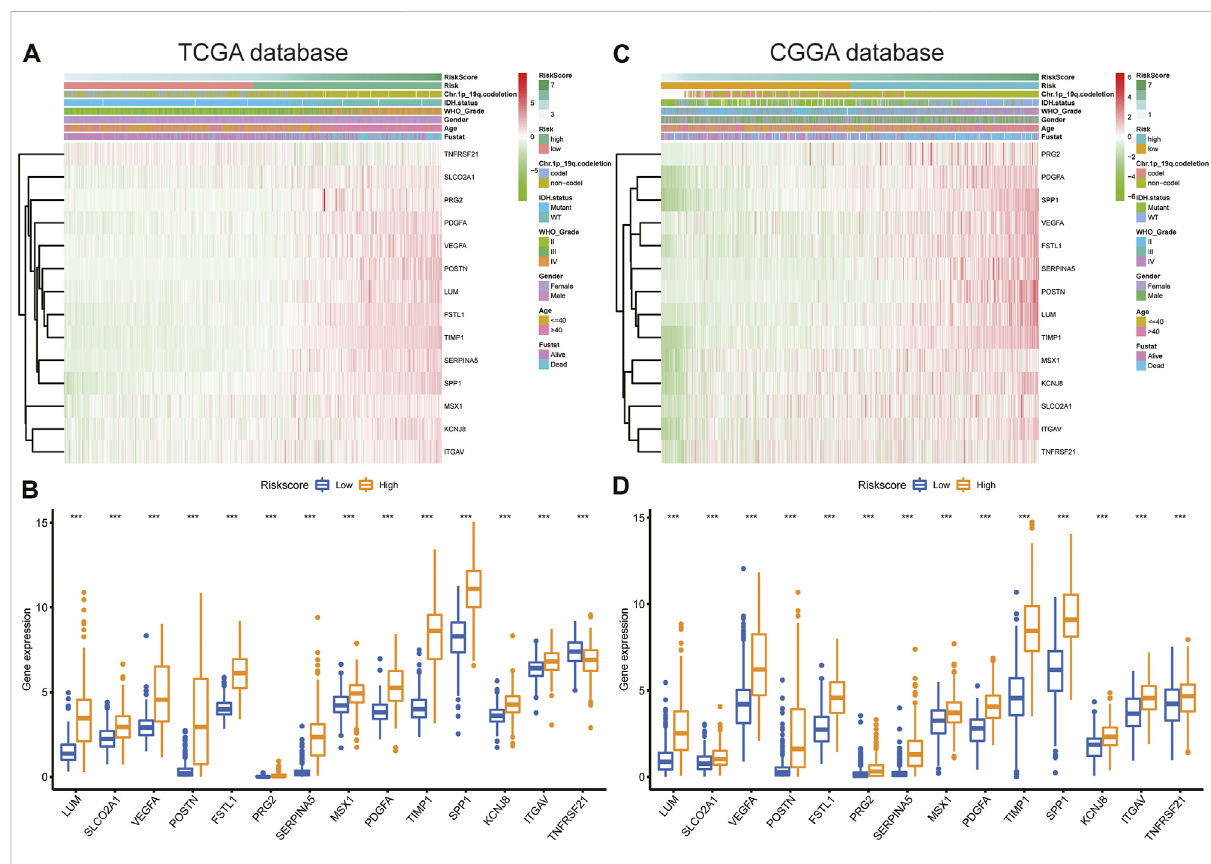
FIGURE 5 (A,C) Heatmap of the 14-ARG expression pattern in clinicopathologic characteristics and risk score in the TCGA and CGGA databases. (B,D) Expression differences in the 14 ARGs between the low- and high-risk groups in the TCGA and CGGA